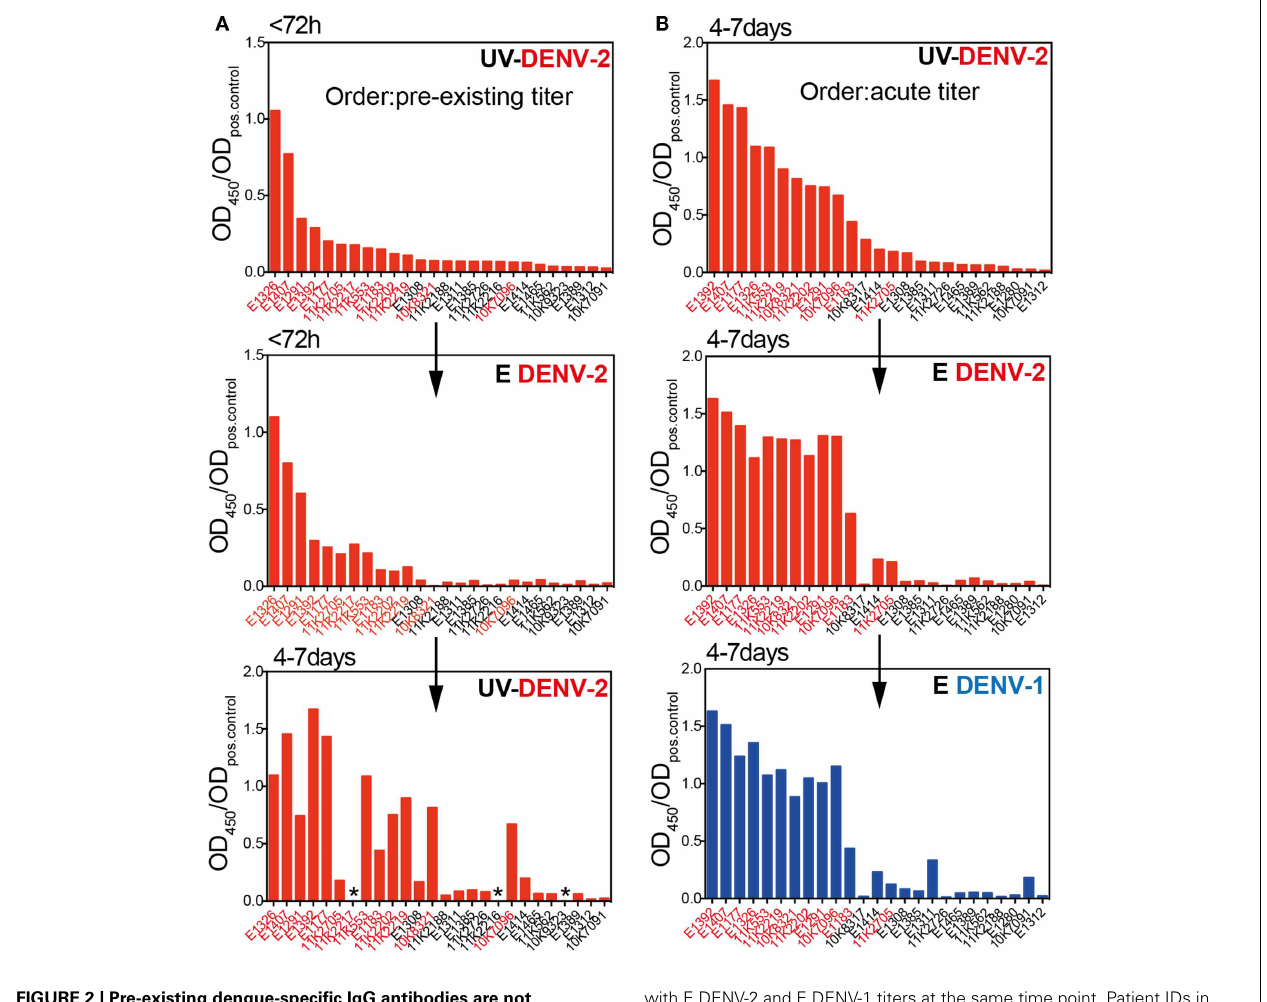
FIGURE 2 | Pre-existing dengue-specific IgG antibodies are not indicative of the anamnestic IgG response 4–7days after fever onset . (A) Plasma samples were sorted according to the UV-DENV-2 titer measured at < 72h and the values were compared with the E DENV-2 titers at the same time point and with UV-DENV-2 titer measured 4–7days after onset of fever. (B) Plasma samples were sorted according to their UV-DENV-2 titer measured at 4–7days after onset of fever and compared